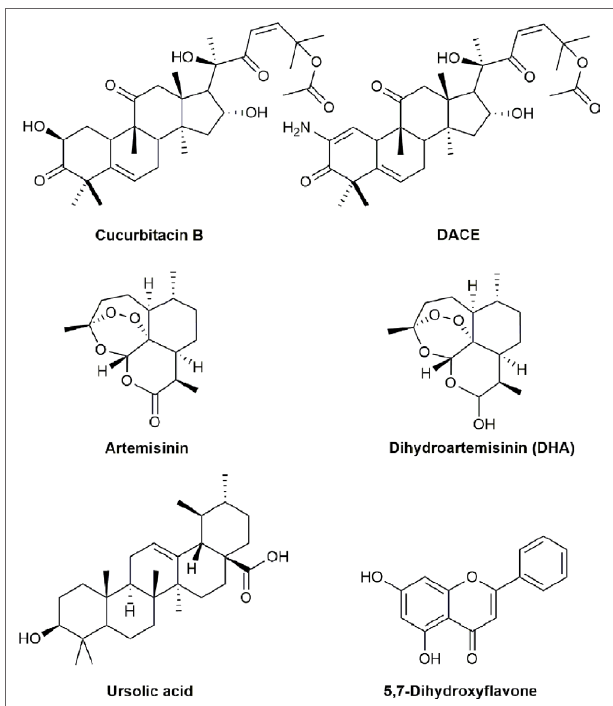
FIGURE 7 | Chemical structures of active compounds derived from anticancer TCMs that primarily target the Janus kinase (Jak)-signal transducer and activator of transcription 3 (STAT3) signaling